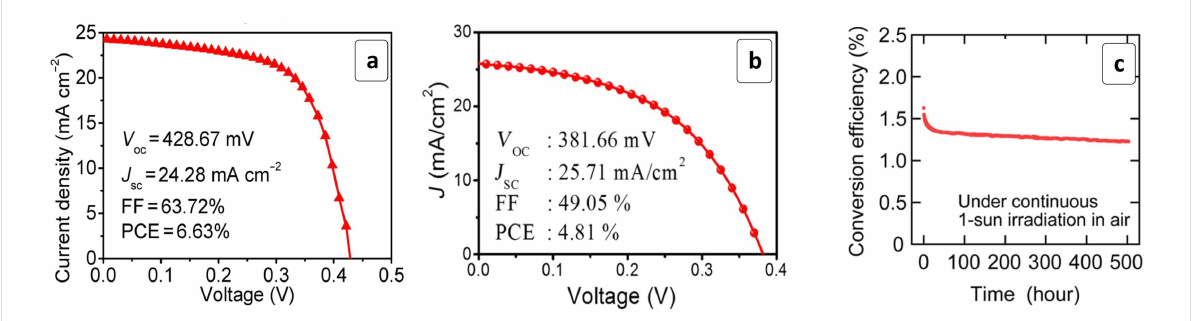
Figure 4: (a,b) Photocurrent density–voltage curves recorded for the solar cells based on MASnI 3 HPs (a) and CsSnI 3 HPs (b); (c) test of prolonged performance stability of a solar cell based on MASnI 3 HPs. (a) Reprinted with permission from [71], copyright 2017 American Chemical Society; (b) Reprinted with permission from [80], copyright 2017 American Chemical Society; (c) Reprinted with permission from [118], copyright 2017 Amer- ican Chemical Society.